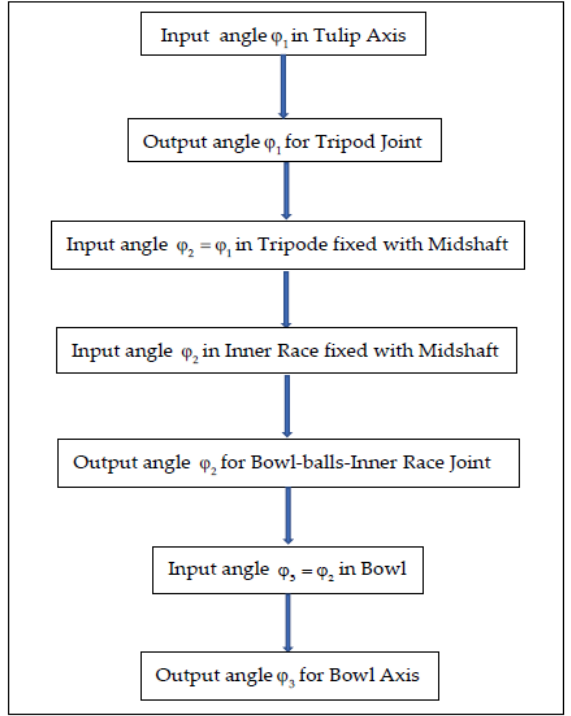
Figure 3. Flow chart of a CVJ driveshaft.